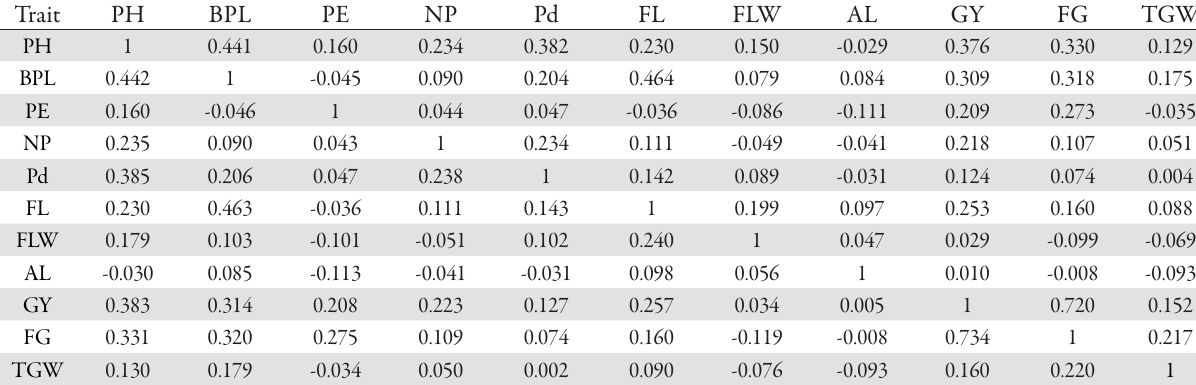
Tab. 3. Genotypic (below diagonal) and phenotypic (above diagonal) correlation coefficients among traits in the 160 F individuals Trait